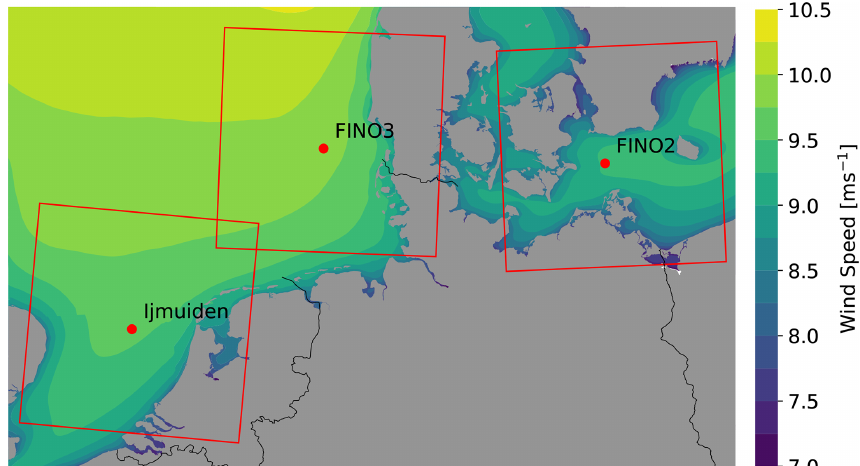
Figure 1. Position of the three sites (met masts) investigated in the framework of this study. The red boxes mark the sizes of the innermost domains used for the mesoscale modelling (see 2.2). The background wind field represents the 30-year mean wind speed (1989–2018) at 100m height above the sea surface taken from the New European Wind Atlas (Hahmann et al., 2020; Dörenkämper et al., 2020). The coastline and border data originate from the GSHHS dataset (Wessel and Smith,